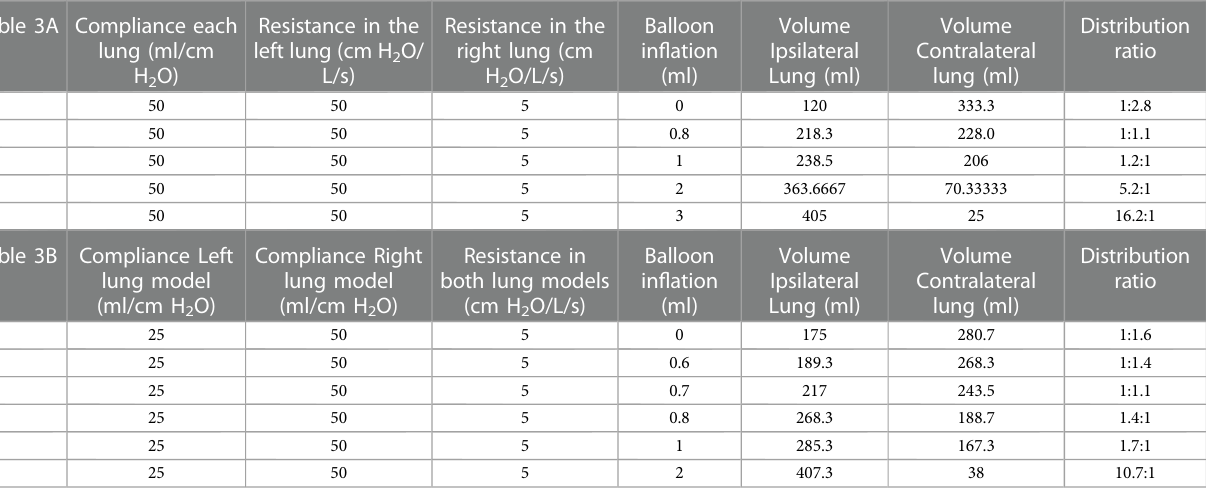
Table 3B Compliance Left lung